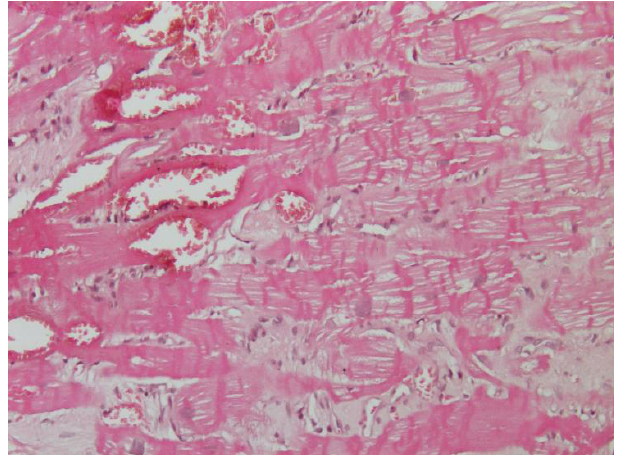
Figure 3. Hematoxylin and eosin staining (200×) shows the hypercontraction of sarcomeres with contraction band necrosis and lymphocytic infiltration due to catecholamine overproduction from pheochromocytoma.